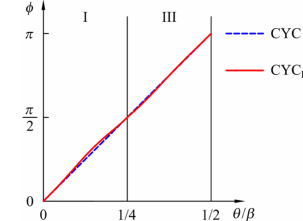
Figure 4. Variation in phase angle function in Example 1.